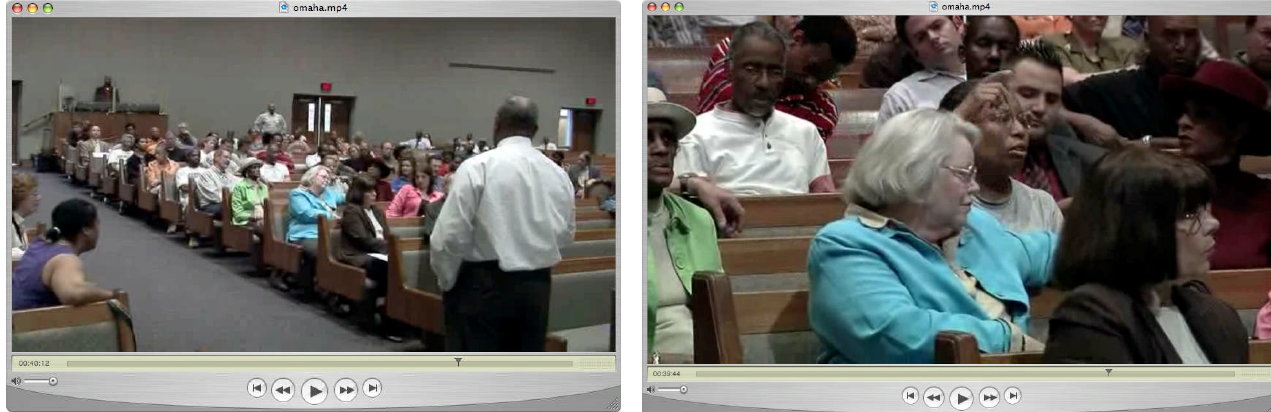
[start 40:03 – end 40:14] 40:03 Lady: You’re not in this then 40:14 Okay then but I’m talking about the target area (with finger